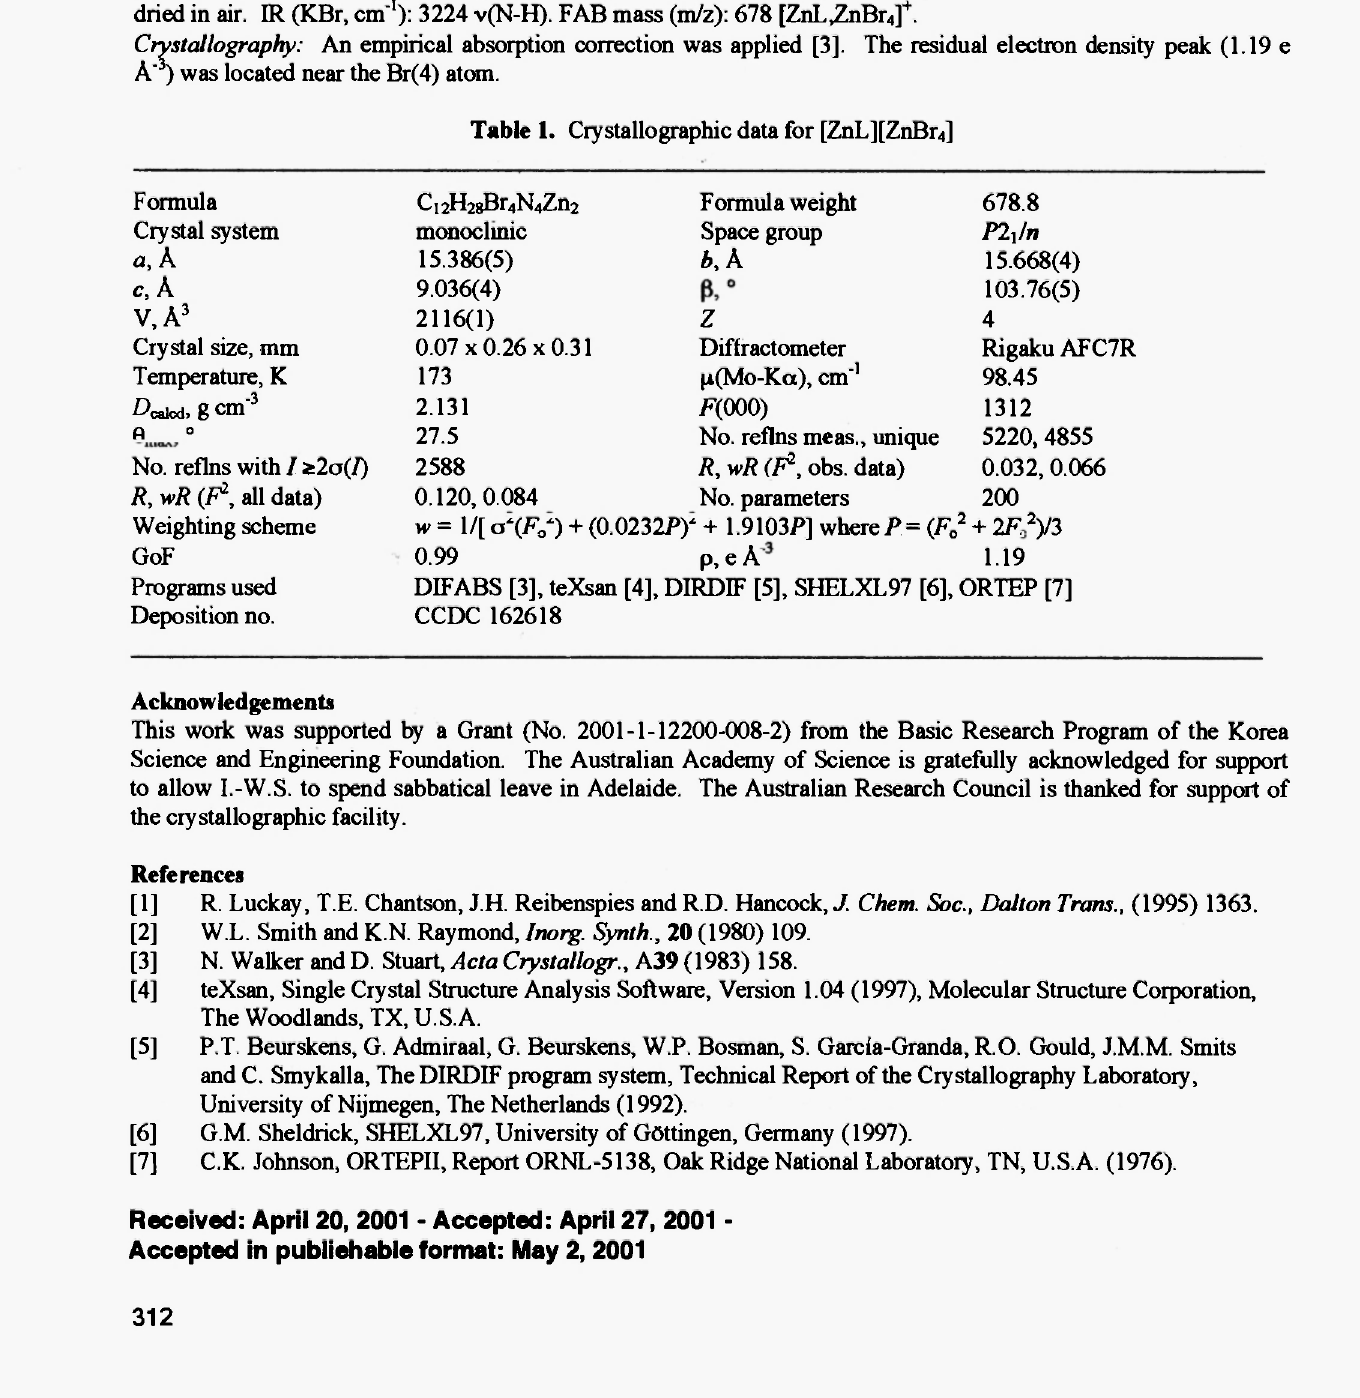
Table 1. Crystallographic data for [ZnL][ZnBr 4